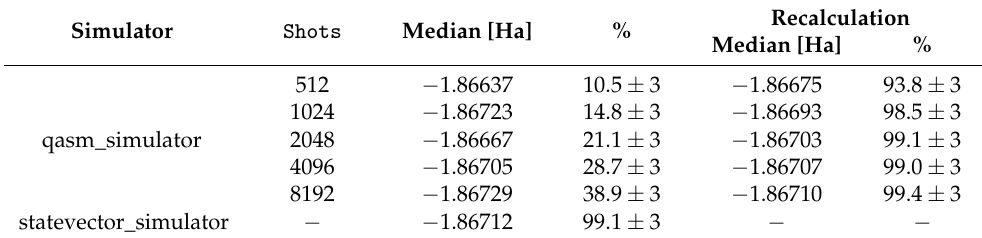
Table A1. Summary of the medians of 1000 optimized ground-state energies and the percentage of outcomes that were found within chemical precision of exact energy ( − 1.86712 ± 0.0015 Ha) for different settings of shots parameter and maxiter = 1000. Additionally, in the middle two columns, the final energy is the direct outcome of the SPSA algorithm and the last two columns show the recalculation using the statevector simulator. The R y variational ansatz was used. The error margin of 3 percent was estimated based on the standard deviation of 1000 identically distributed trials. These data are the basis for Figure 2.